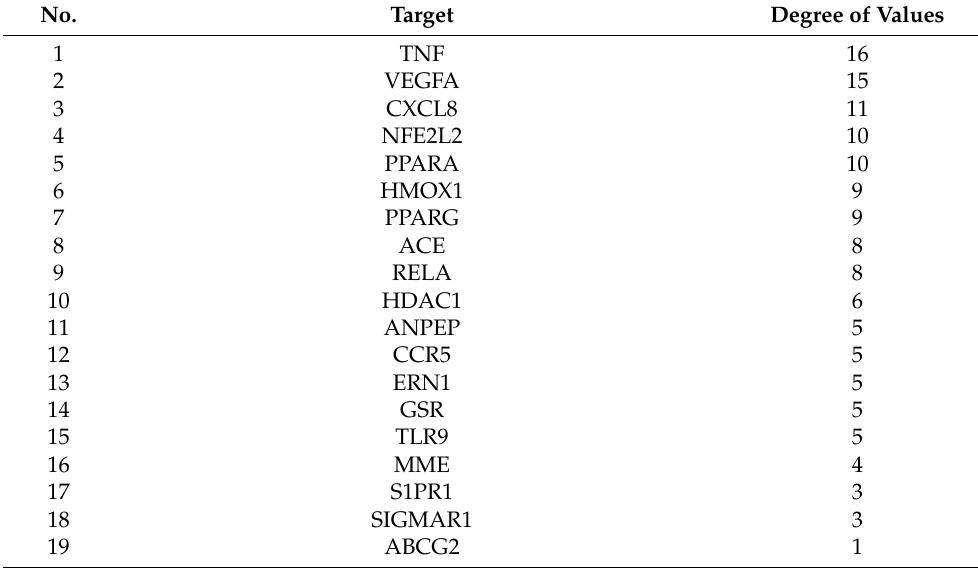
Table 2. The degree value of targets in PPI